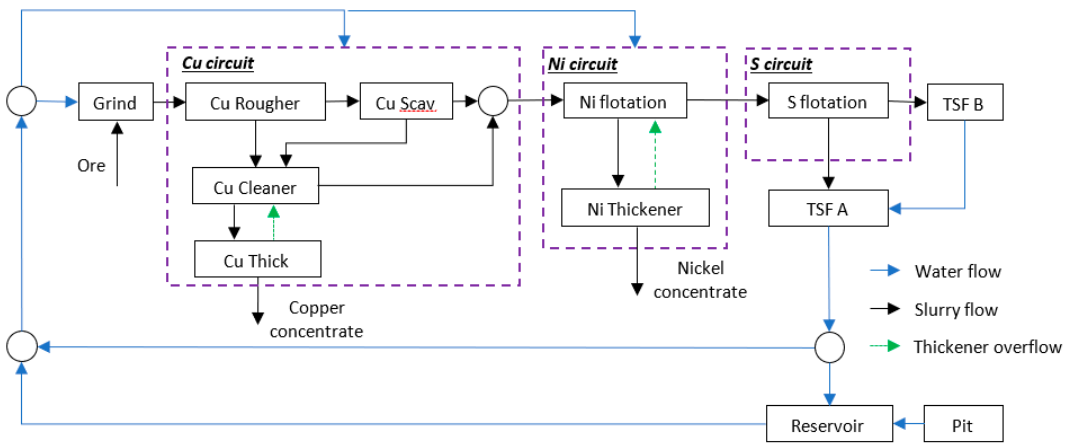
Figure 1. Flotation and water circuits of the Boliden Kevitsa mine .